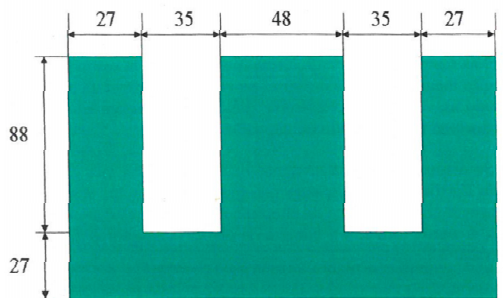
Figure 2. Dimensions of a ferromagnetic sheet (mm) [16].